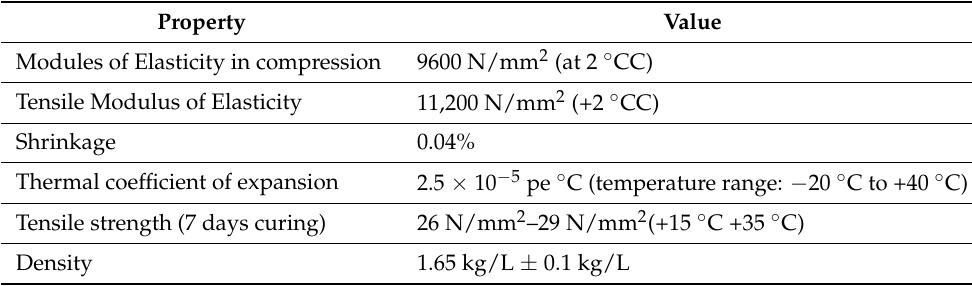
Table 3. Properties of epoxy adhesive [21].